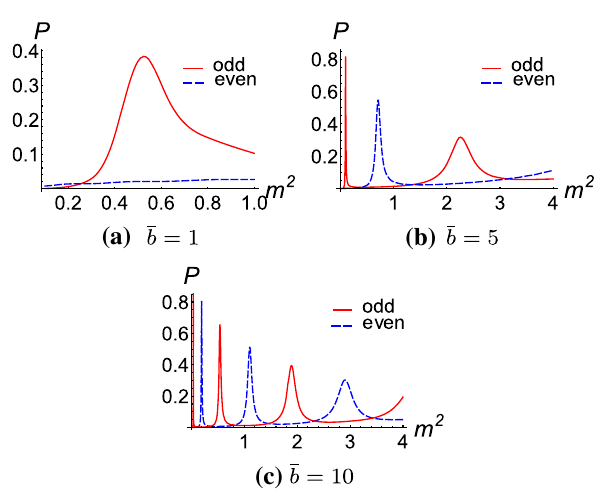
Fig. 8 The relative probability P for different values of ¯ b for f ( T ) = T + ¯ α T 2 . The parameter is set to ¯ α = − 1 k 2